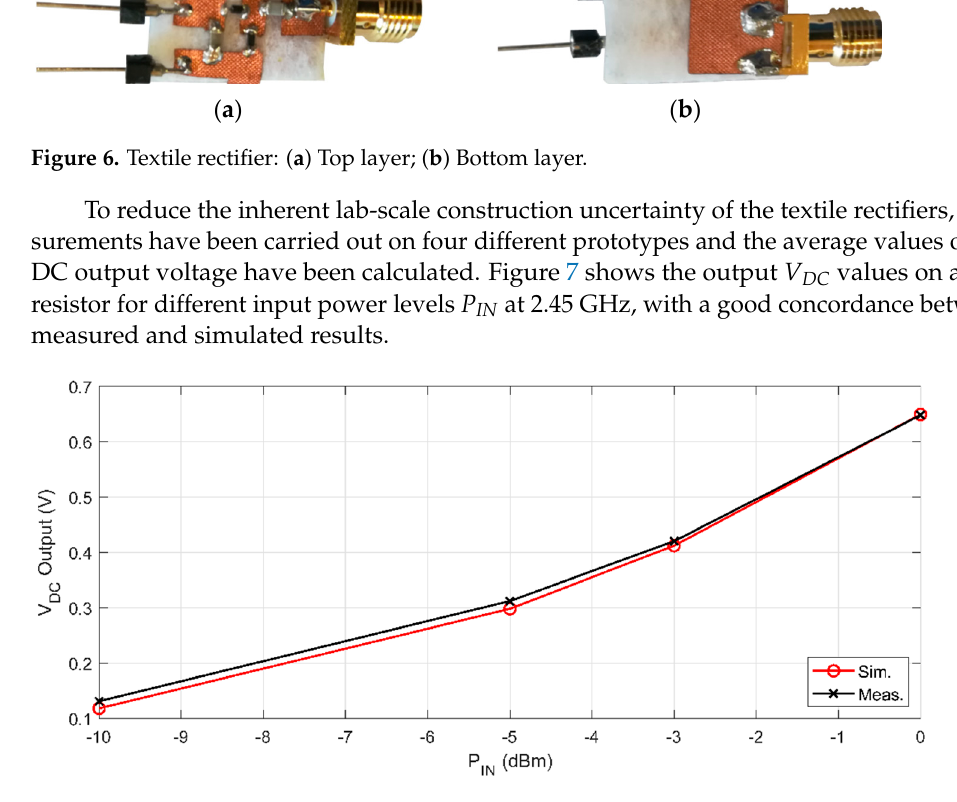
Figure 7. Textile rectifier output V DC vs. input power P IN (2.45 GHz).